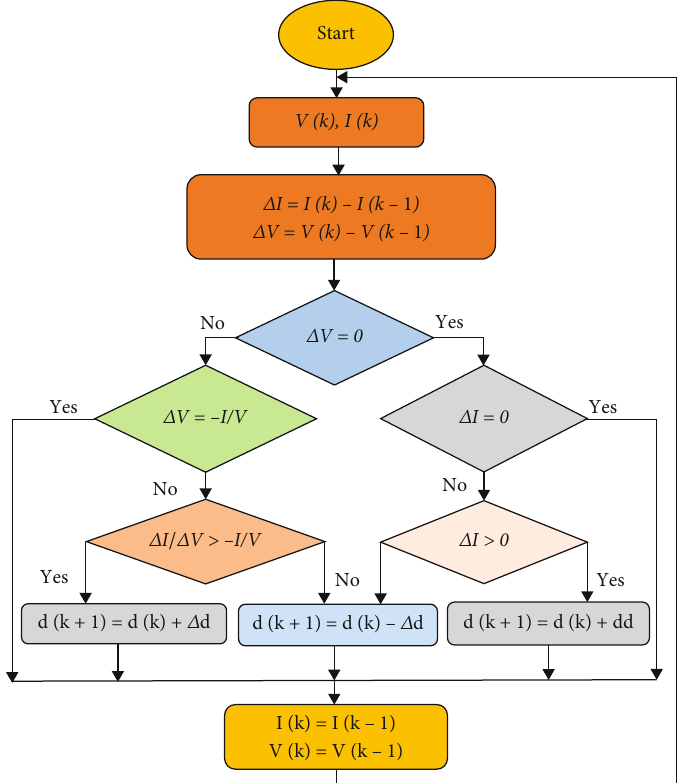
Figure 7: Flowchart of the INC MPPT scheme.